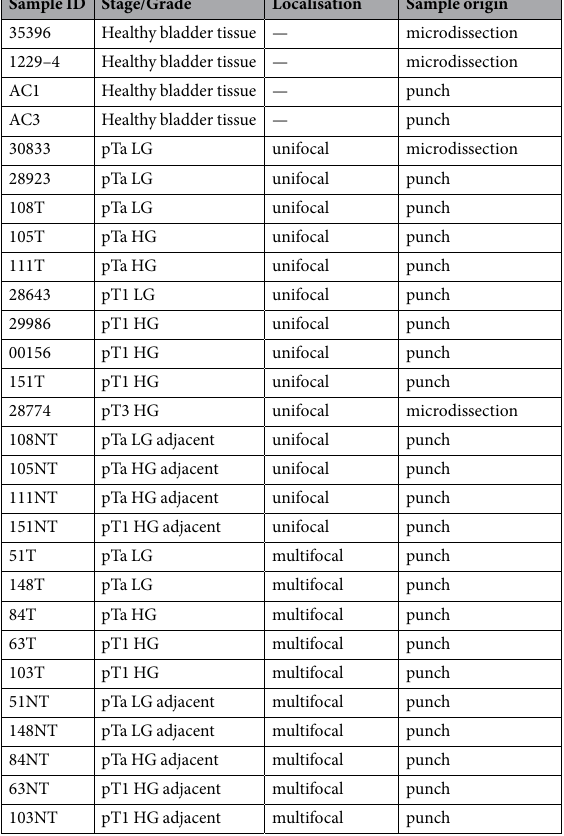
punch Table 1. Overview of used healthy and tumor-adjacent urothelial and UC tissue